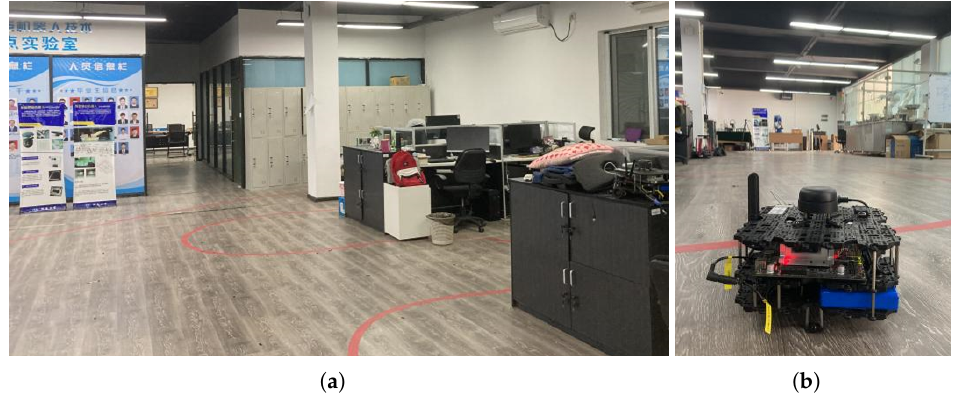
Figure 3. ( a ) The indoor environment. ( b ) The data-collection